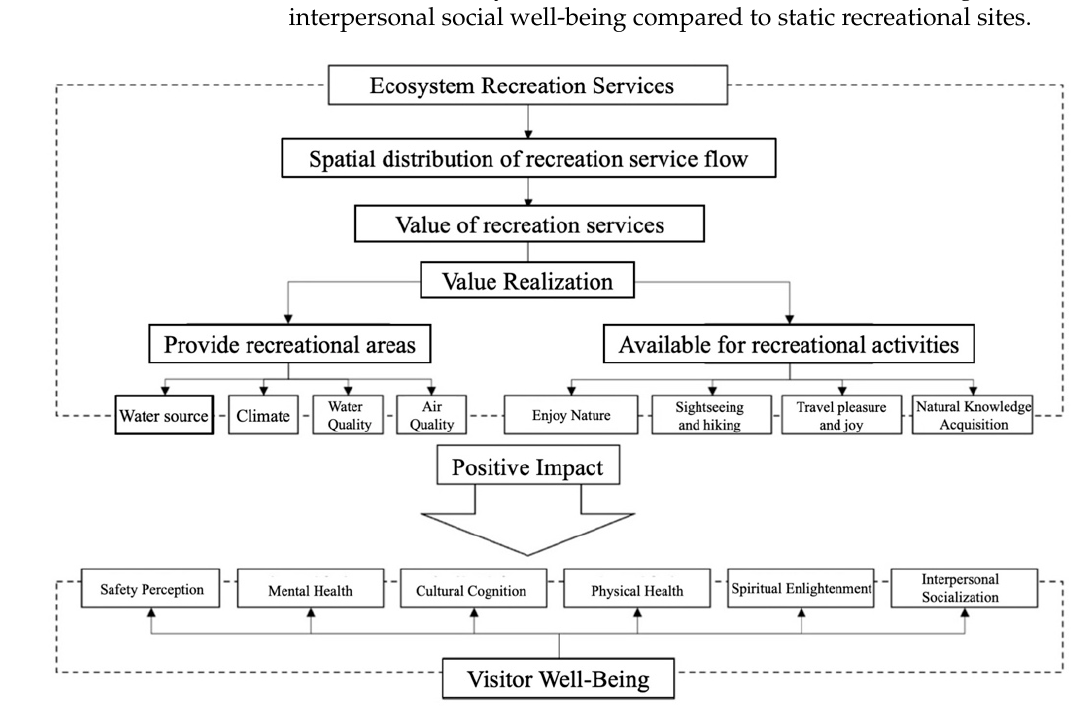
Figure 5. Model of the impact of ecosystem recreational services on the well-being of tourists.